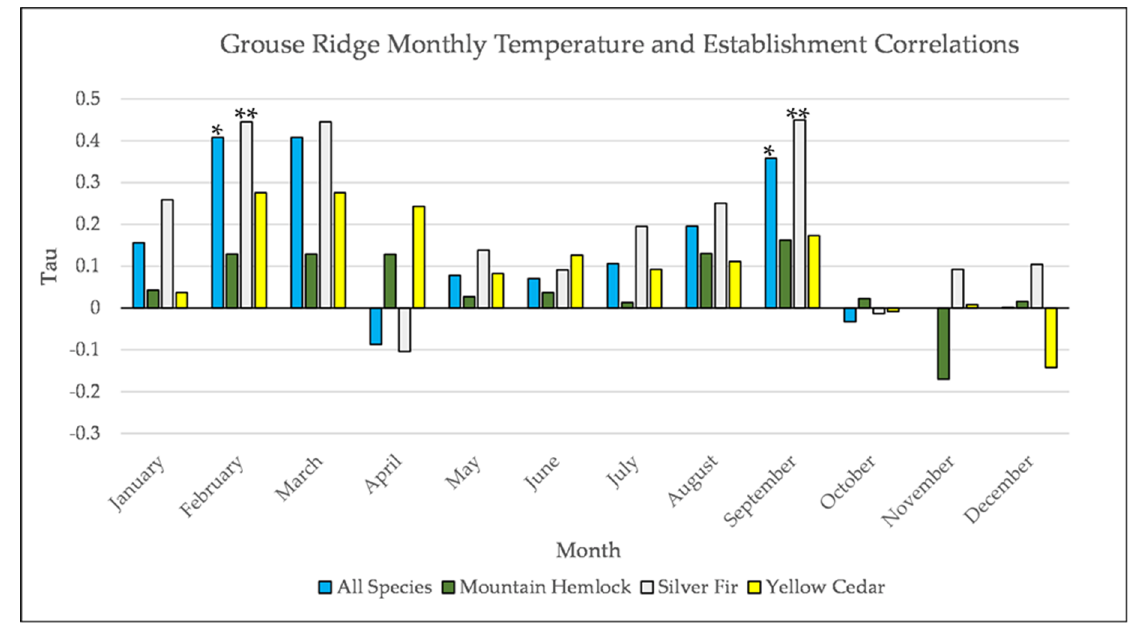
Figure A11. Partial Kendall’s correlation between mean monthly temperature and establishment at the Grouse Ridge site* = p -Value < 0.05, ** = p -Value < 0.01.